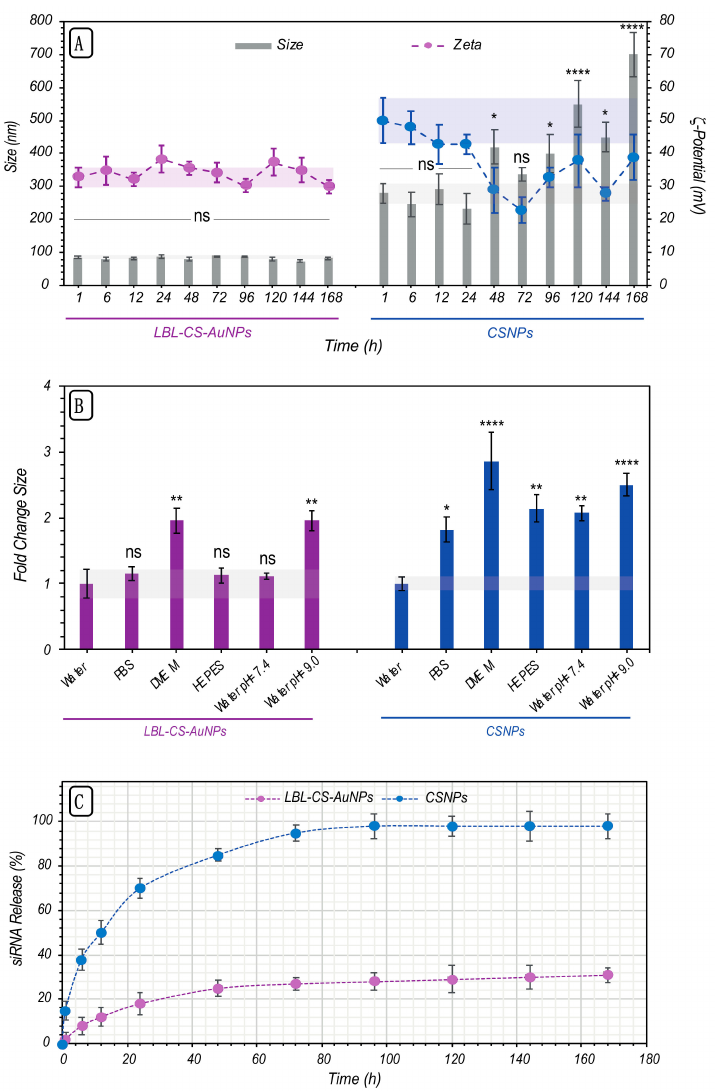
Figure 4. Comparison of siRNA release and colloidal stability between LBL-CS-AuNPs and CSNPs. ( A ) Size and zeta potential analysis in DDI water as a function of time for LBL-CS-AuNPs and CSNPs. ( B ) The fold change in particle size of LBL-CS-AuNPs and CSNPs in different media is shown as measured after 1 h incubation. ( C ) Percentage of siRNA released from LBL-CS-AuNPs and CSNPs in pH 7.4 HEPES buffer at 37 ◦ C as a function of time. Data are represented as mean ± the standard error of the mean for a minimum of three independent experiments. Statistical significance, with respect to water, is indicated when appropriate (ns = not significant p > 0.05, * p ≤ 0.05, ** p ≤ 0.01, **** p ≤